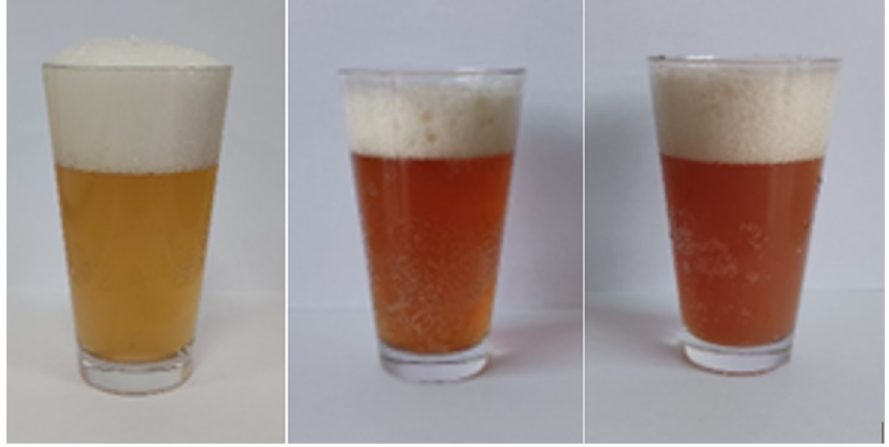
Figure 2. The appearance of the obtained wheat beers with addition of the Saskatoon berry fruits (from left to right)—CB—control beer, TB0—cv. ‘Thiessen’ with ozone-treated fruit and TB1—untreated fruit.